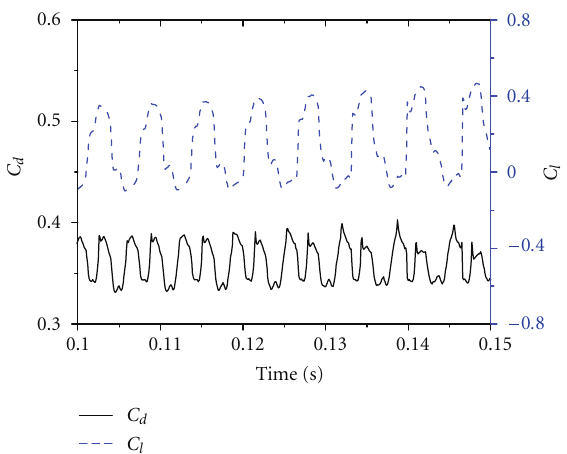
Figure 17: Variation of C d and C l along with σ v , h/H = 0 . 75, σ v = 1 . 808, wake-vortex type cavity.